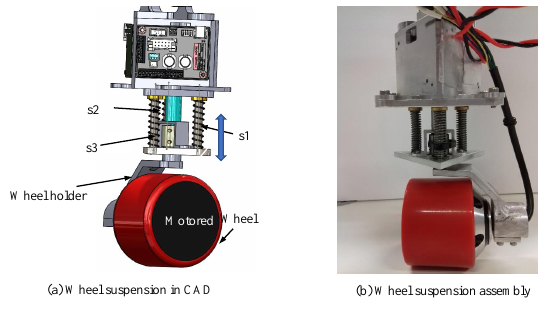
Figure 6. Wheel with